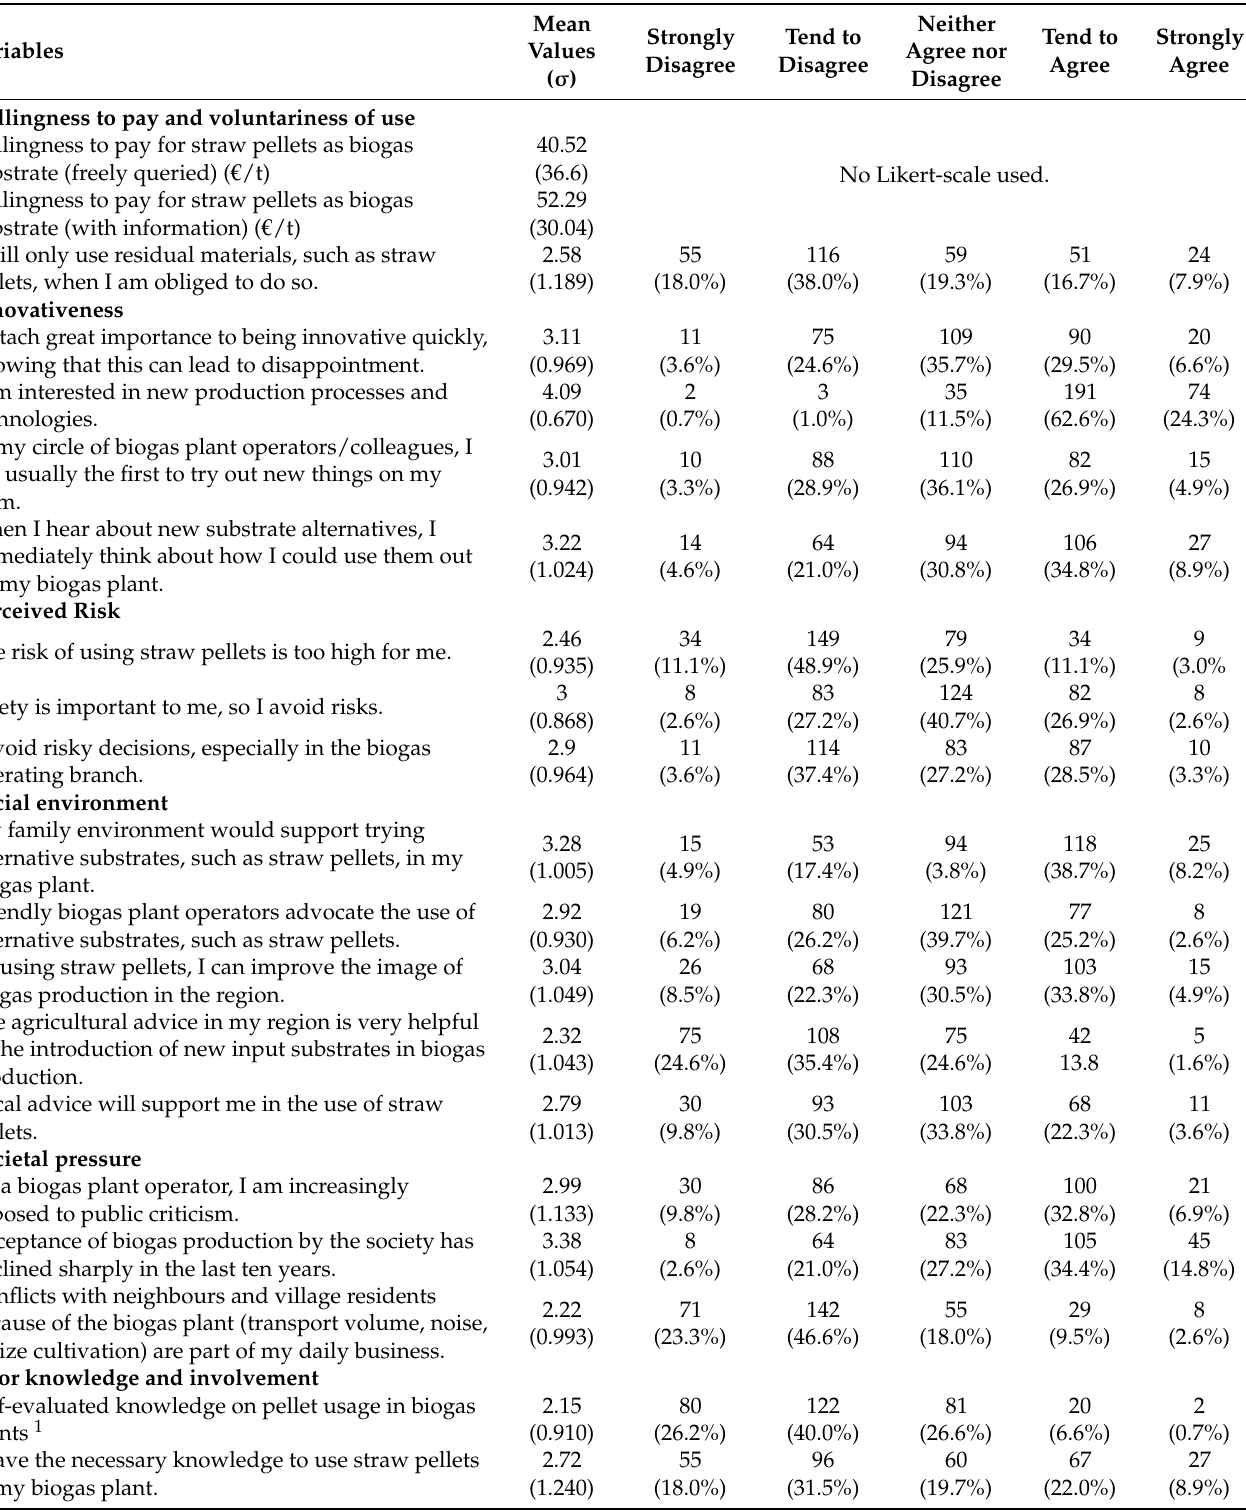
Table A2. Descriptive statistics corresponding to Table